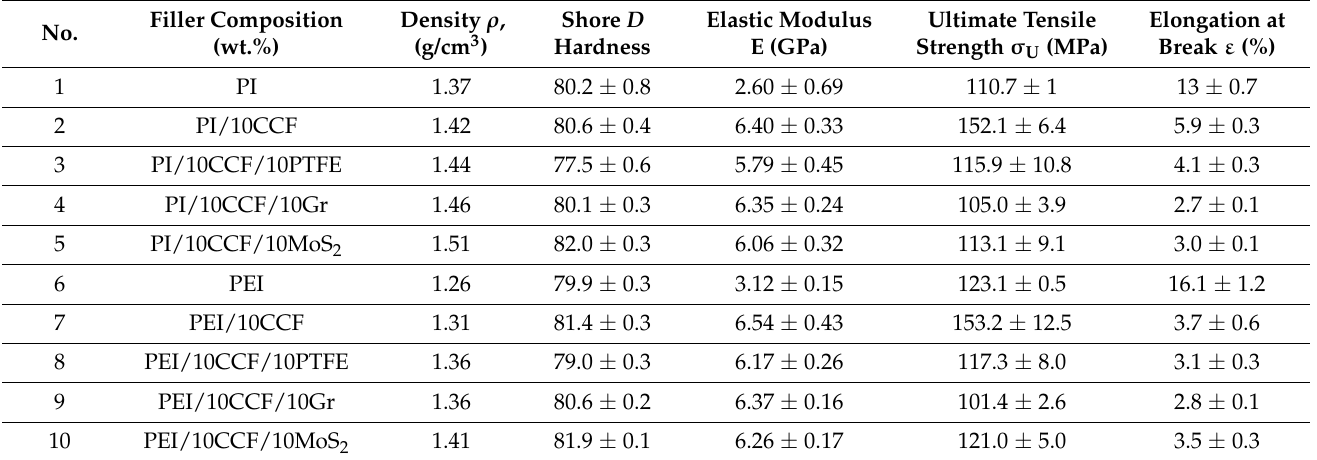
Table 1. The physical and mechanical properties of neat PI and PEI, as well as their